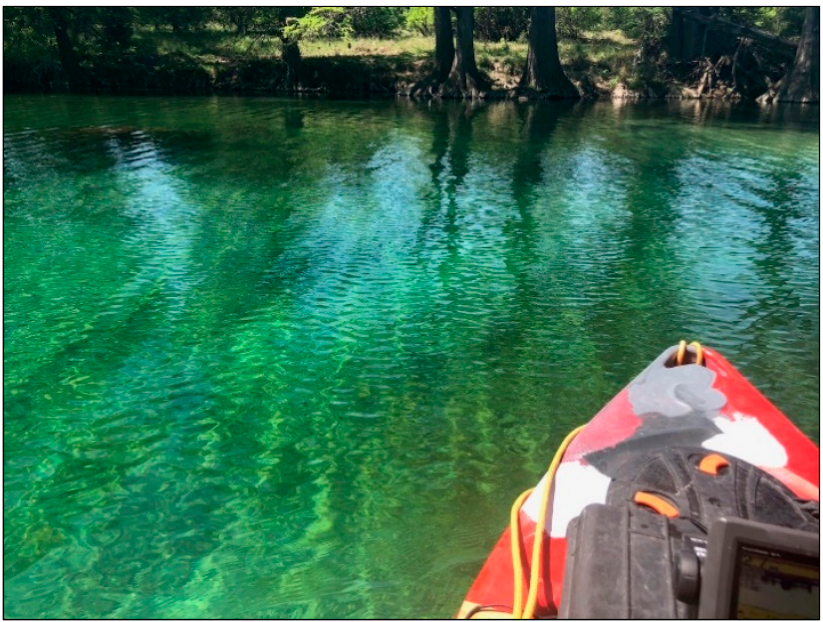
Figure 7. Calm and shallow waters of the Frio River.